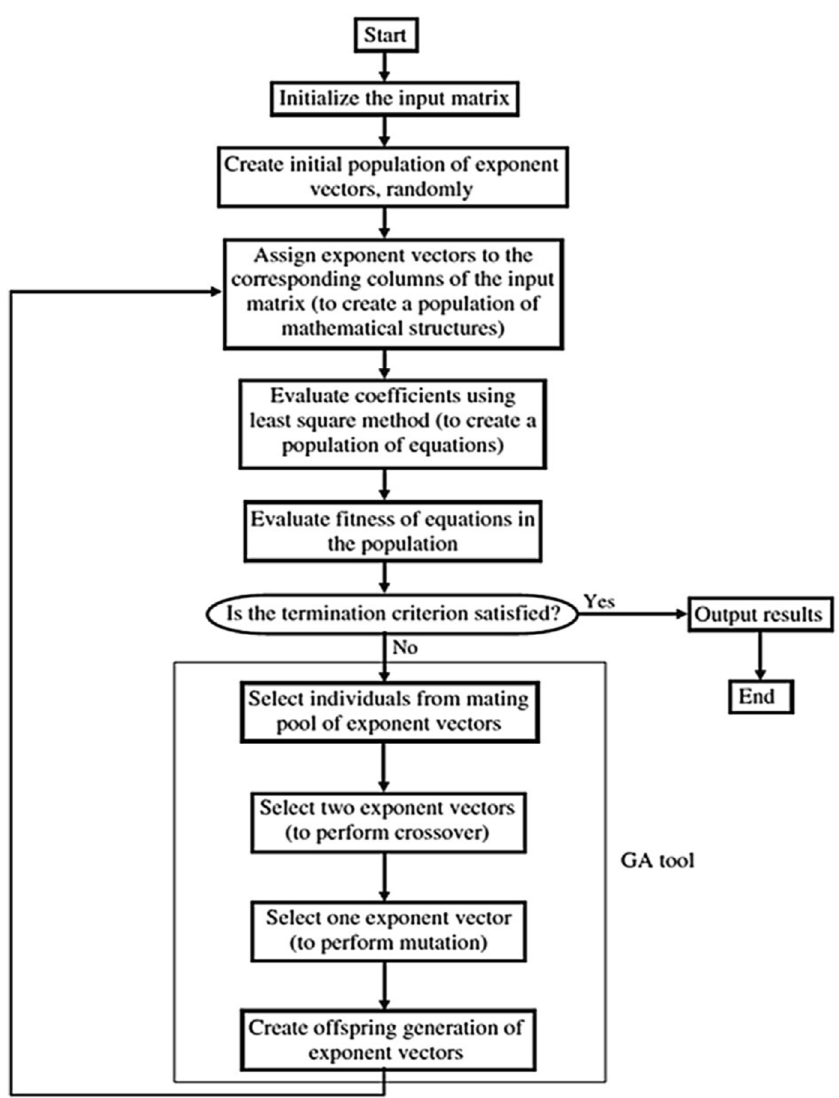
Figure 4. Typical flow diagram of the evolutionary polynomial regression (EPR) procedure [46], reproduced with permission from Springer Nature.